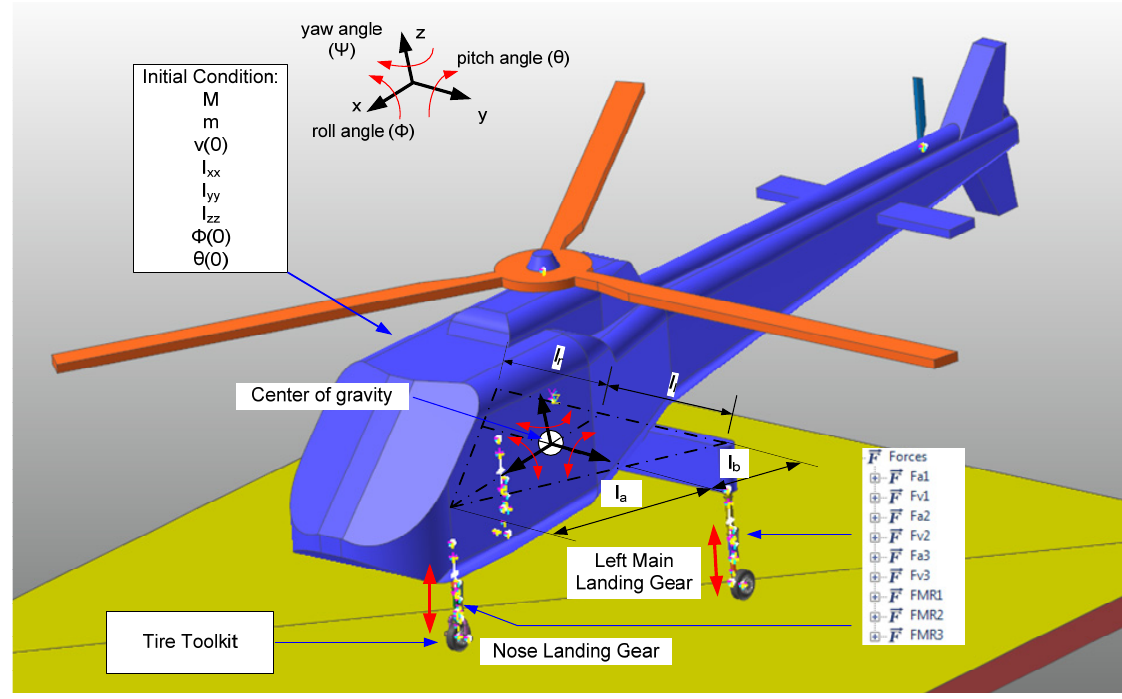
Figure 3. Helicopter with 3 landing gears in RECURDYN. Table 1. Helicopter parameters.